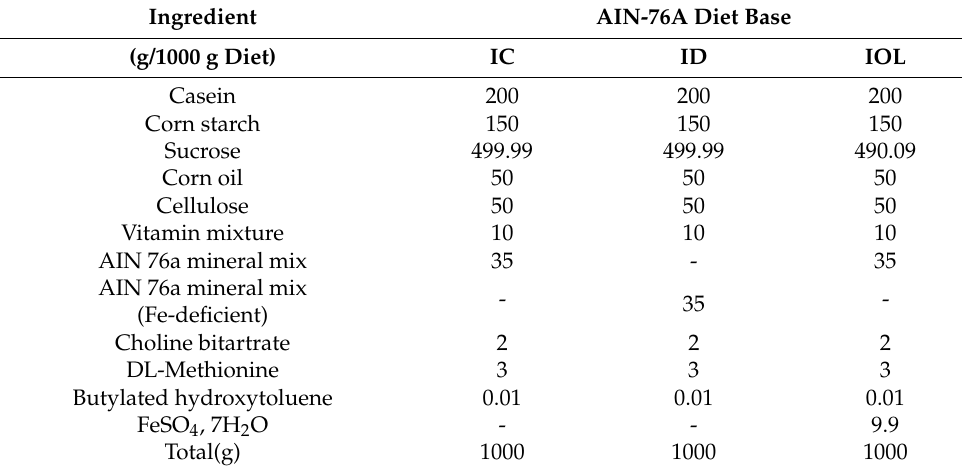
Table 1. Composition of different iron